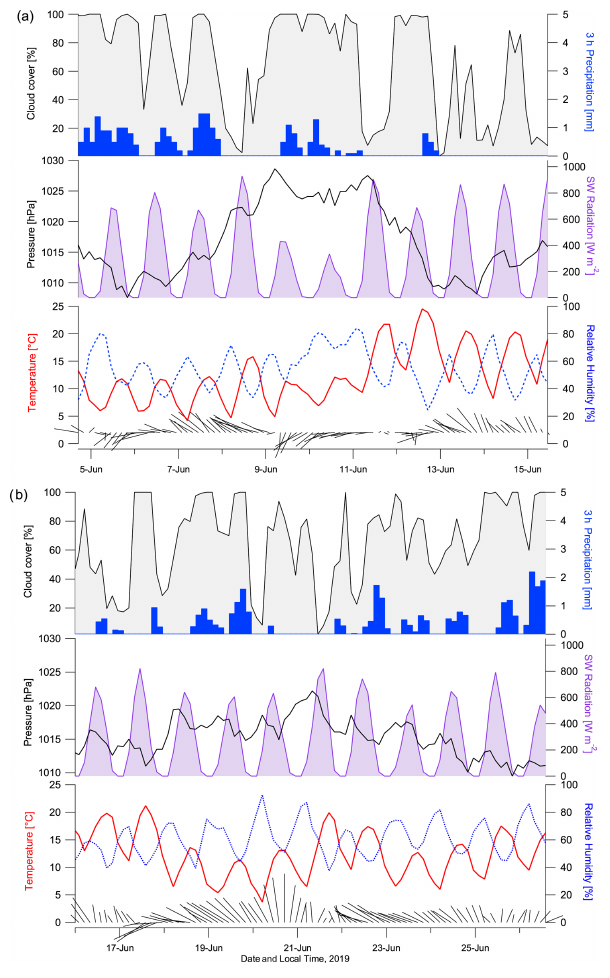
Figure 2. Meteograms for the study periods at the (a) Eagle Lake and (b) Nazko River sites. Wind direction and speed are indicated by barbs at the bottom of the plots. (All data are from the NARR, North American Regional Reanalysis,